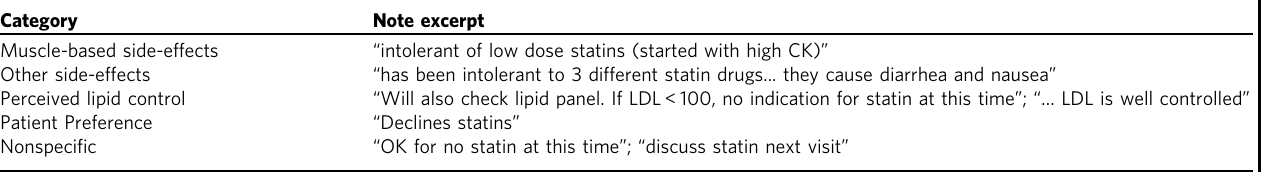
Table 4 Excerpts from clinical notes demonstrating the reasons for statin nonuse identi fi ed in this